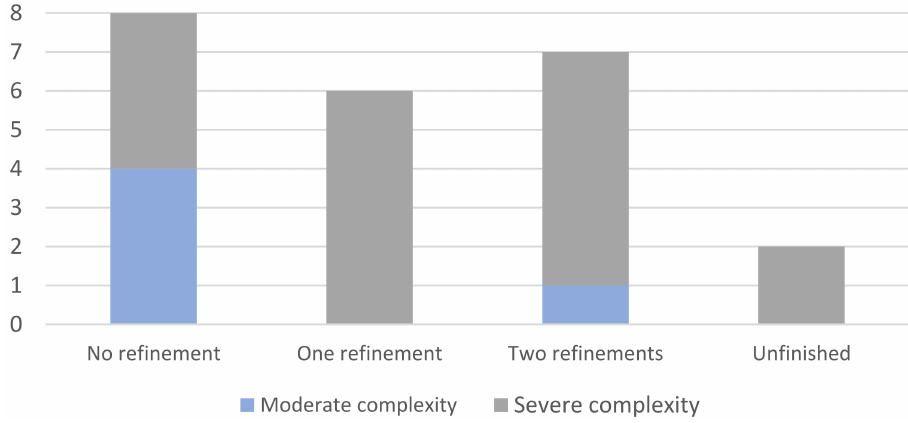
Figure 2. The relationships between the global complexity classification of the included cases and the number of additional aligners required to achieve all treatment objectives for the patient ( N = 23).